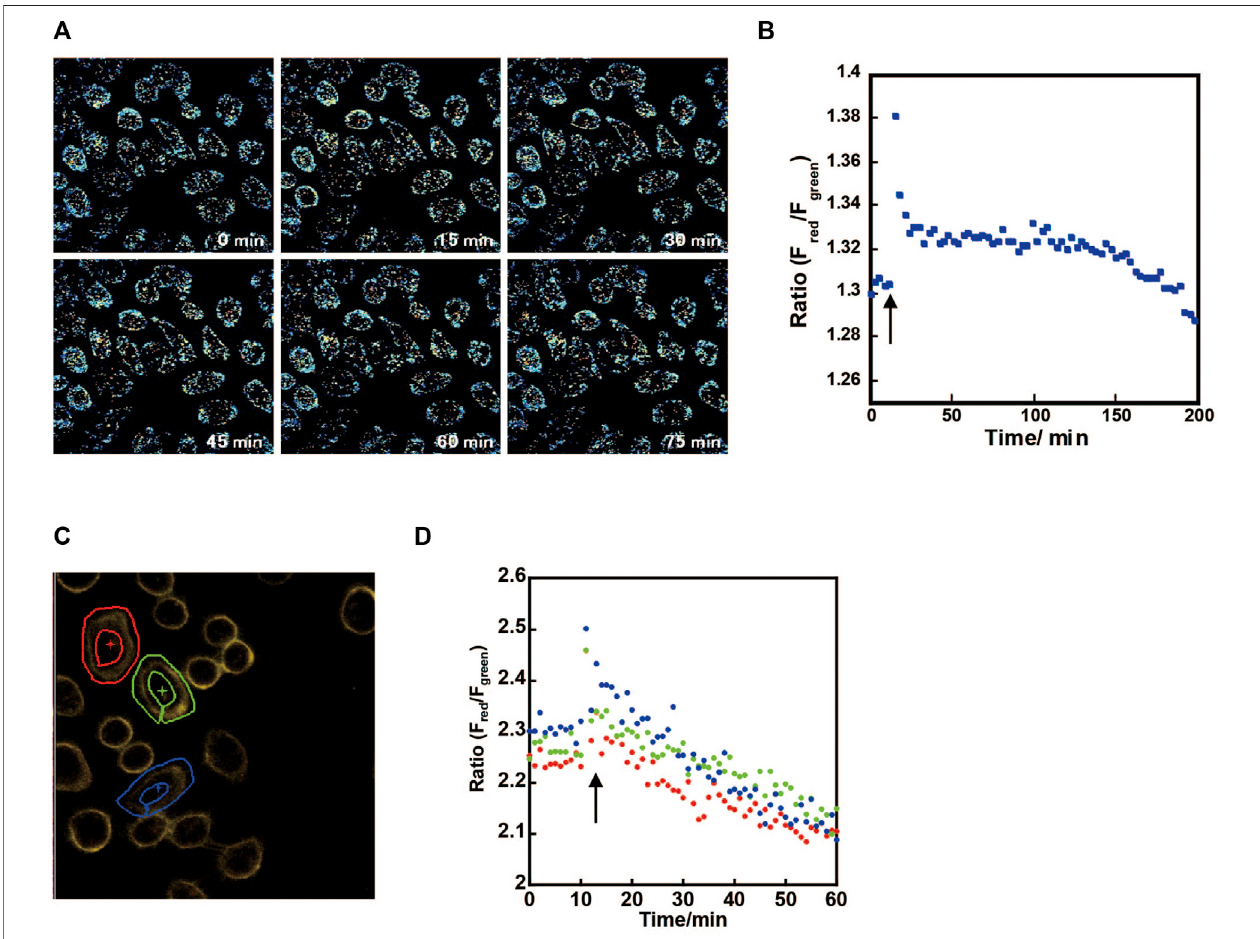
FIGURE 5 | (A) Cell surface imaging by 1 -StAv-ConA after adding 10 μ M Amphotericin B, 10 μ M Bumetanide, and 10 μ M Ouabain/DMEM at 11 min ( ↑ ), (B) fl uorescence ratio of F – 595 nm,/F – 528 nm), λ red/ F green (F red : F.I. of 575 green : F.I. of 508 ex = 488 nm in all cells. (C) Extracell imaging by 1 -StAv-sulfo-NHS-biotin and (D) fl uorescence ratio of F – 620 nm, F – 554 nm), λ μ M Amphotericin B at 11 min ( ↑ ). The three cells red/ F green (F red : F.I. of 554 green : F.I. of 500 ex = 488 nm after adding 26 shown in (C) were surrounded by ROI (region of interests), and their fl uorescence ratios were shown in (D)